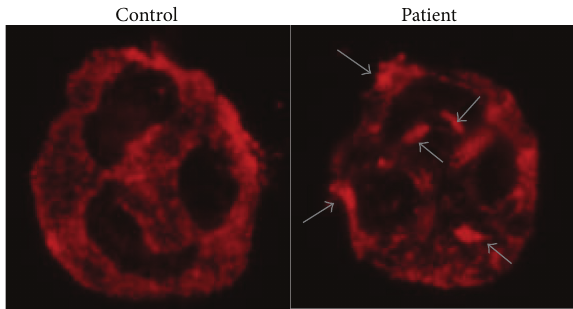
Figure 1: The result of immunofluorescence analysis of periph- eral blood smears. The arrow shows abnormal type II aggrega- tion/accumulation of NMMHC-IIA within the cytoplasm of gran-